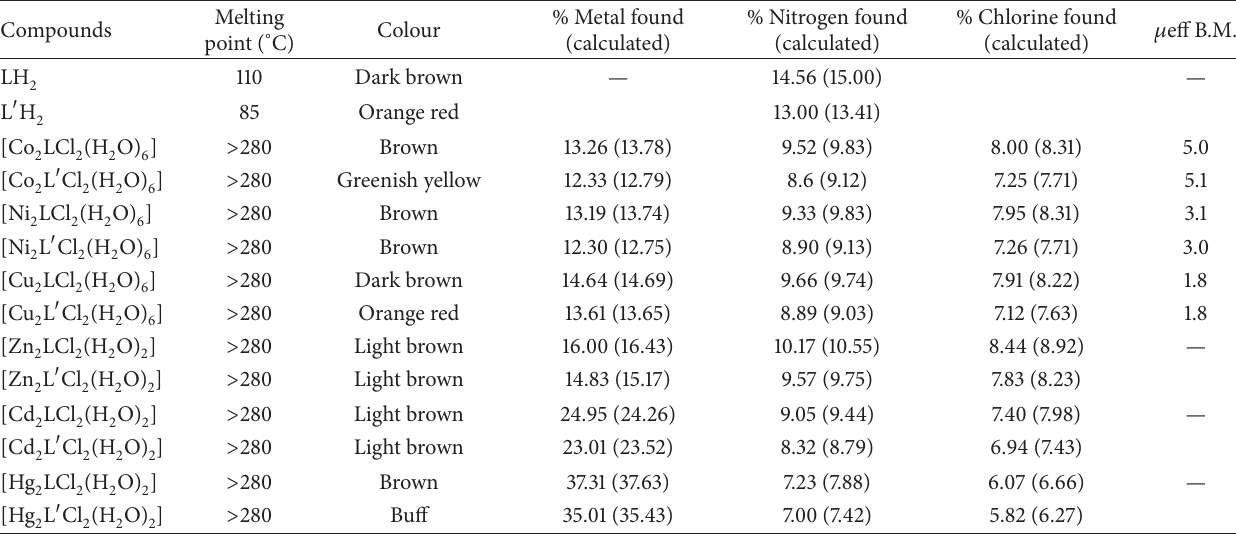
Table 1: Analytical and physical data of the ligands and its complexes.